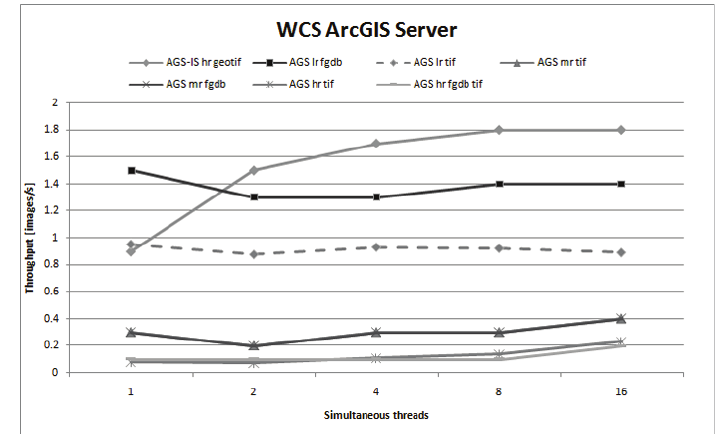
Figure 6: WCS ArcGIS Server tests